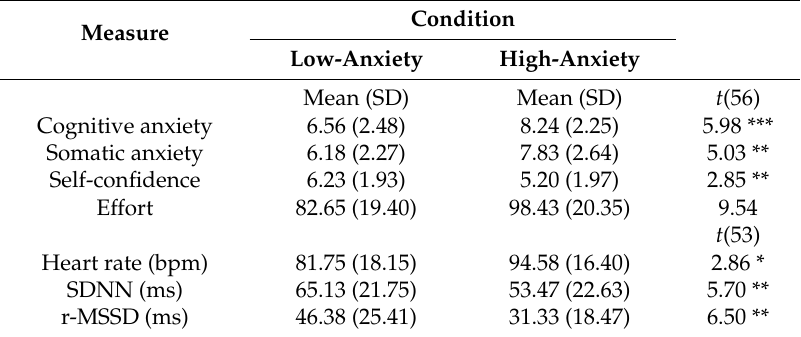
Table 1. Descriptive statistics confirming the effectiveness of the anxiety